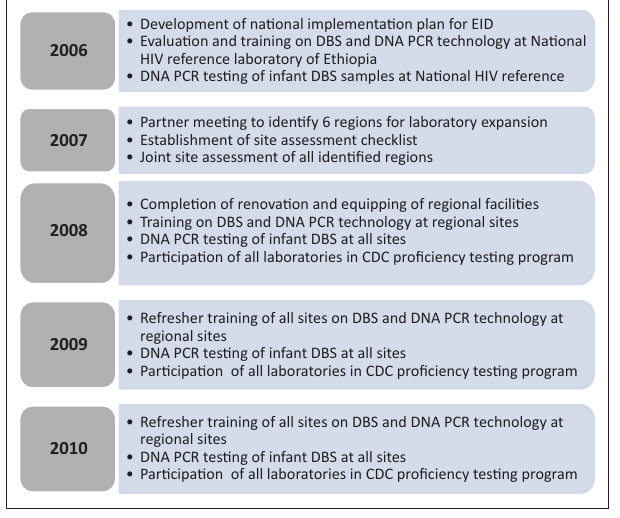
EID, early HIV infant diagnosis; DBS, dried blood spot; PCR, polymerase chain reaction; CDC, Centers for Disease Control an Prevention. FIGURE 1: Milestones in expansion of laboratory services for early HIV infant diagnosis in